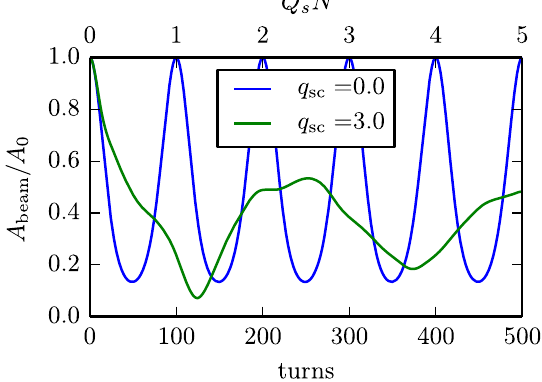
FIG. 7. Stroboscopic plot for 21 particles for the combination of space charge and chromaticity: Δ Q ξ ∈ ½ − 0 . 03 ; 0 . 03 (cid:2) , Δ Q 0 . 05 , Q 4 . 29 , and A 0 ¼ 0 ¼ a . All particles have zero initial amplitude with respect to the beam center. The plot contains 500 betatron periods.